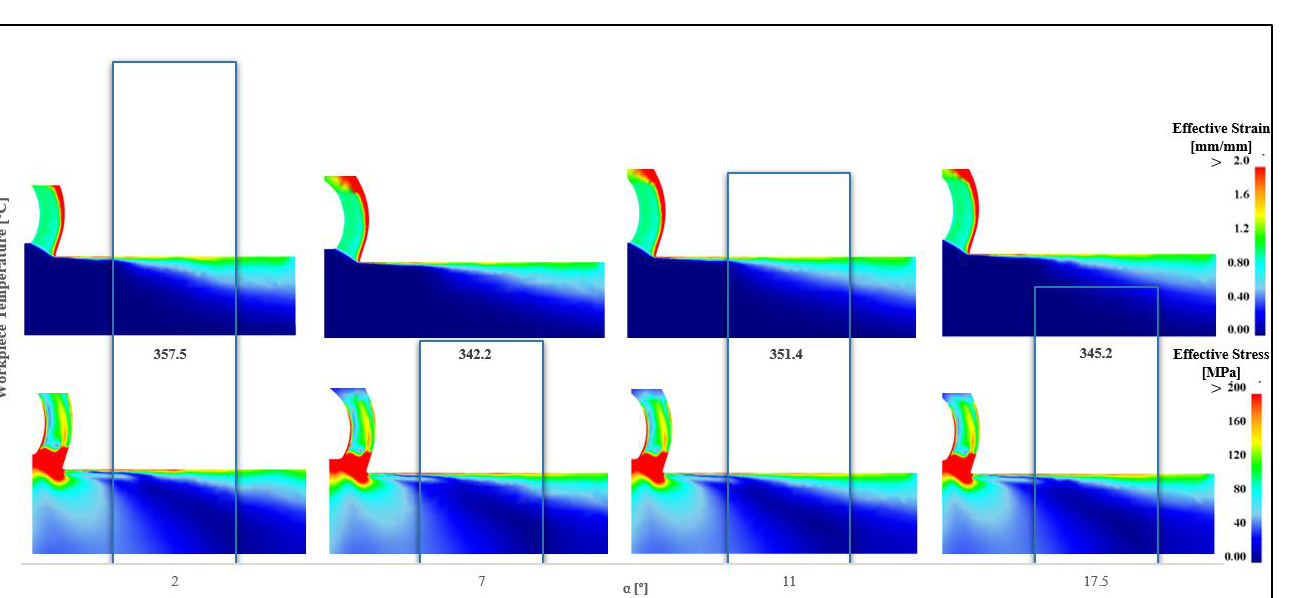
Figure 20. Effect of clearance angle on cutting temperature (r ε = 20 µm and γ = 17.5°): ( a ) 2–7 ° and